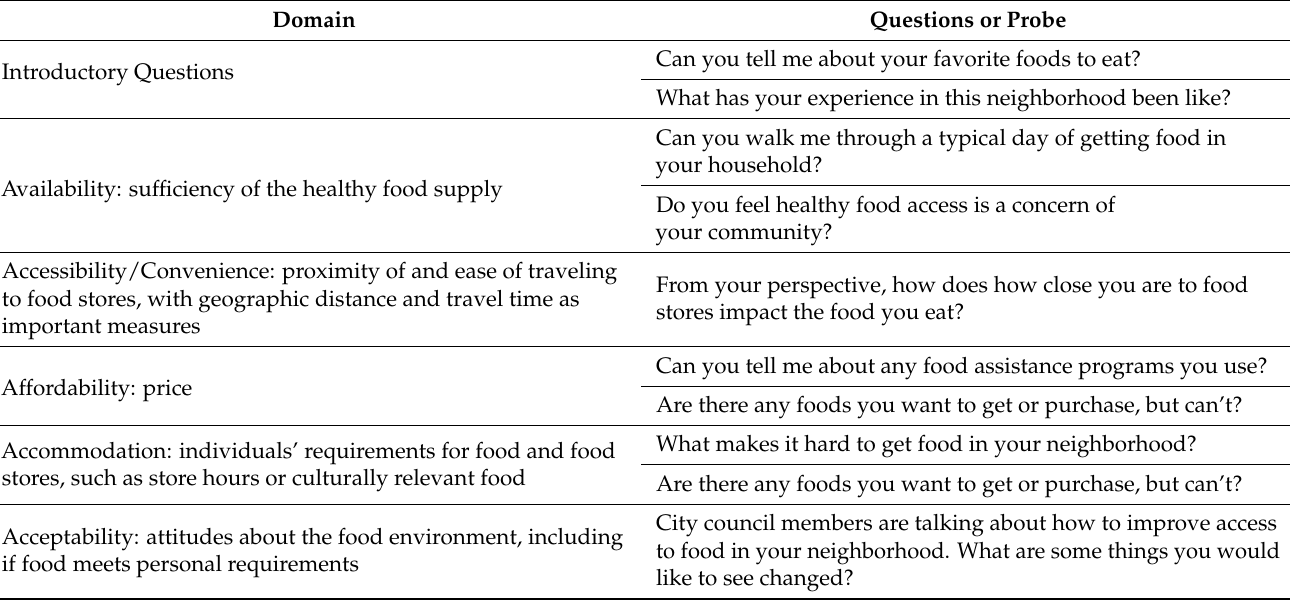
Table 1. Domain Mapping of a Sample of Interview Questions and